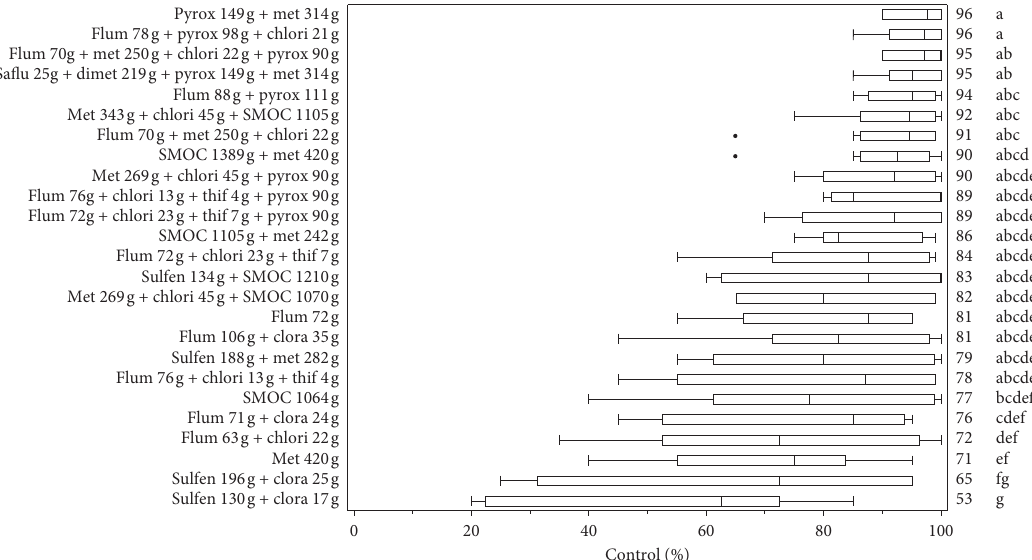
Figure 2: Box and whisker plots for Palmer amaranth control at 28 days after treatment (DAT) over locations in 2017. Statistical means and separation are shown with the corresponding treatment in descending order, derived from a Tukey’s HSD. Each treatment listed included a sample size of 8 data points. Use rates are provided to the right of each herbicides in g ai ha − 1 . a Abbreviations: chlori, chlorimuron-ethyl; clora, cloransulam; dimet, dimethenamid-p; flum, flumioxazin; met, metribuzin; pyrox, pyroxasulfone; saflu, saflufenacil; SMOC, S-metolachlor; sulfen, sulfentrazone; thif,